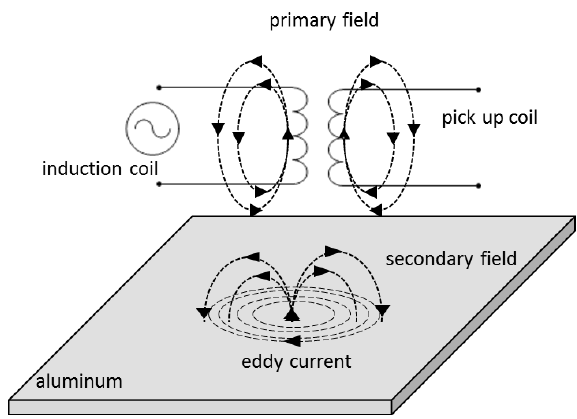
Figure 21. Schematic representation of eddy current (adapted from [133]).